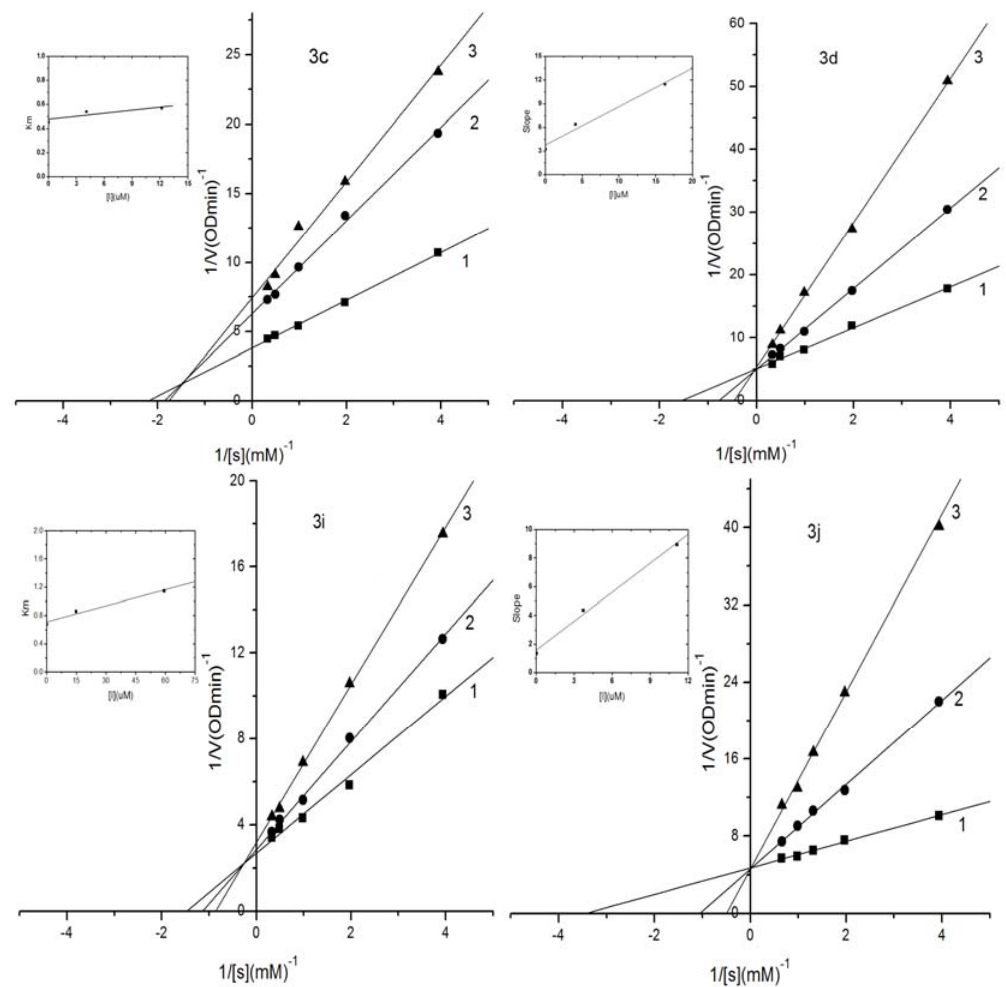
Figure 2. Lineweaver–Burk plots for inhibition of compounds 3c , 3d , 3i and 3j against mushroom tyrosinase for the catalysis of L -DOPA. Concentrations of 3c , 3d , 3i and 3j for curves 1–3 were 0.0 μ M, 4.06 μ M, 12.18 μ M; 0.0 μ M, 4.06 μ M, 16.23 μ M; 0.0 μ M, 14.8 μ